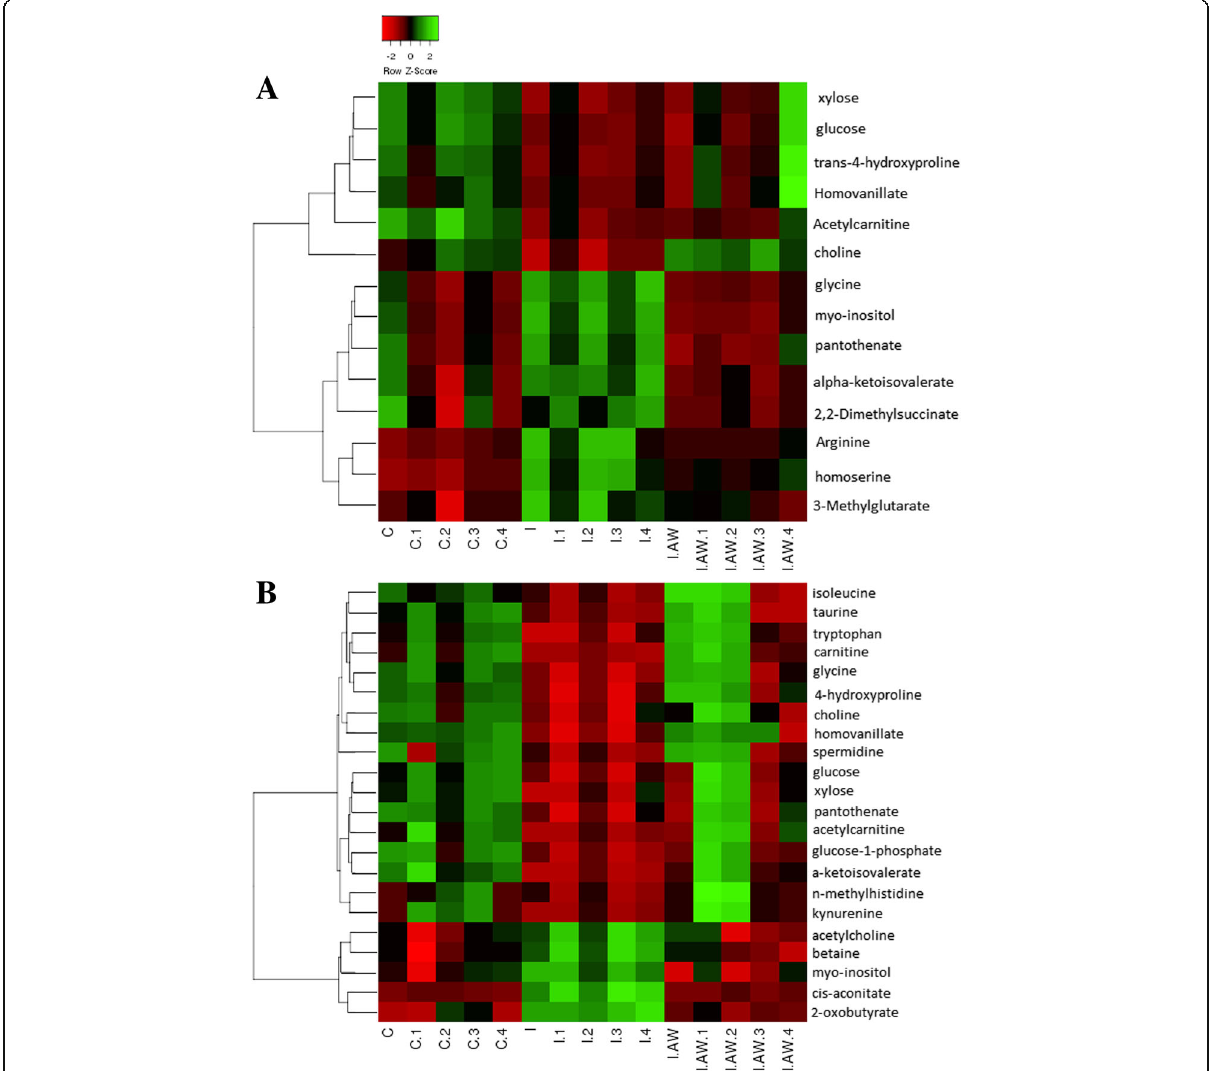
Fig. 11 Heatmap clustering representation of differentially expressed metabolites between the study groups for serum ( a ) and tissue ( b ) samples. ( “ C ” : control group, “ I ” : rats with indomethacin-induced gastric ulcer, “ I.AW ” : ulcerated rats treated with AW